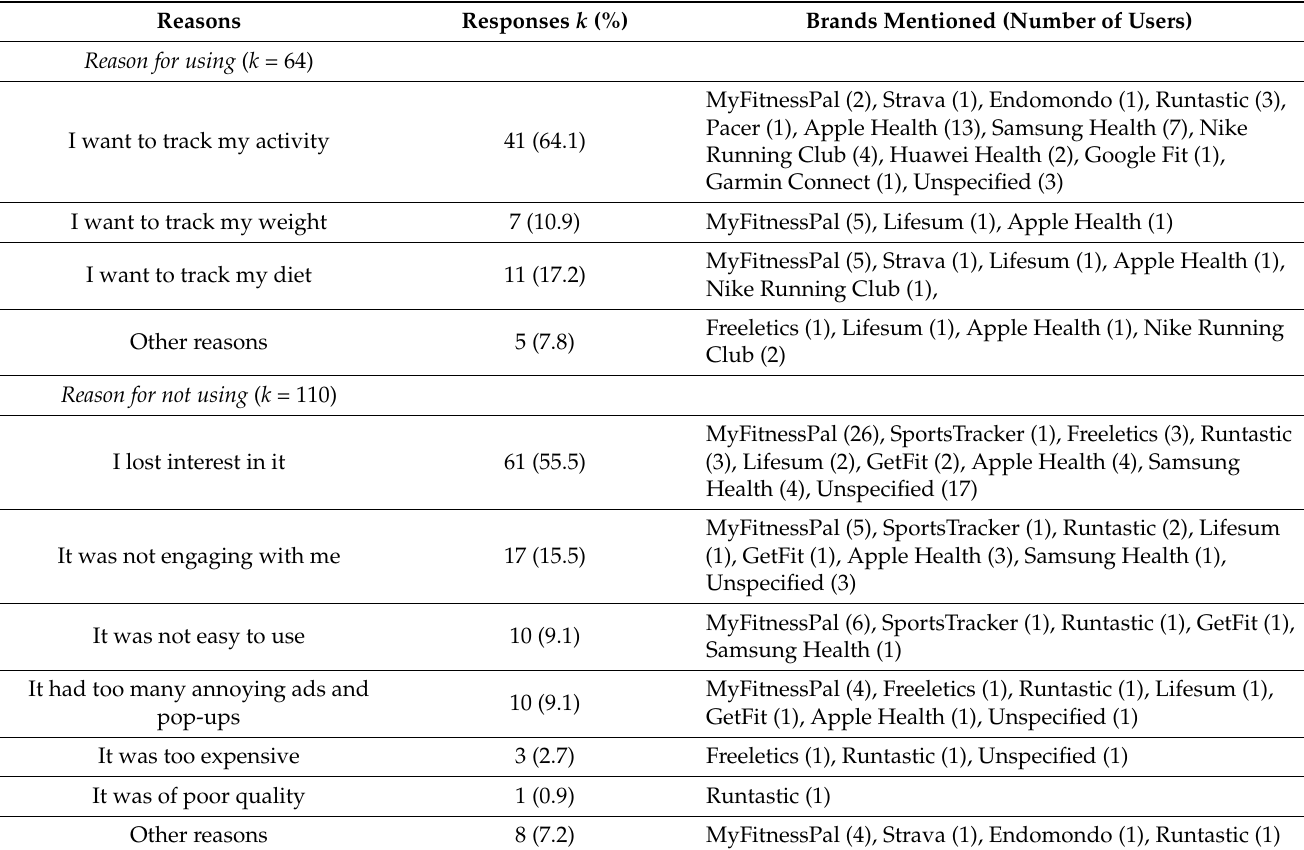
Table 4. Reasons for using and not using health and fitness